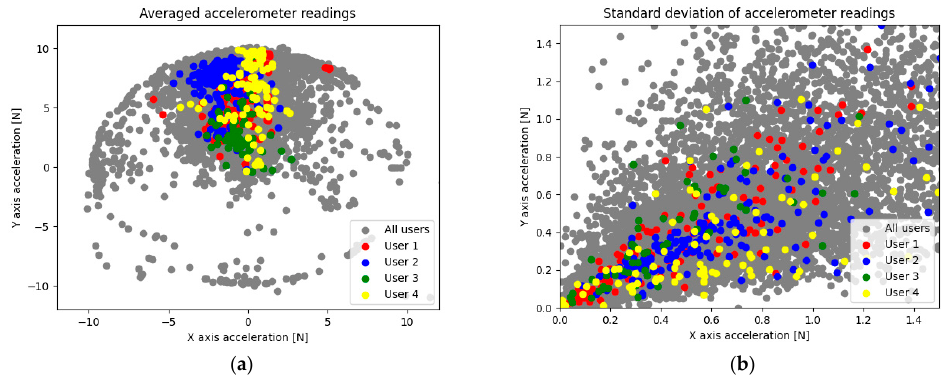
Figure 5. Average ( a ) and standard deviation ( b ) of accelerometers’ x and y axes (all users).